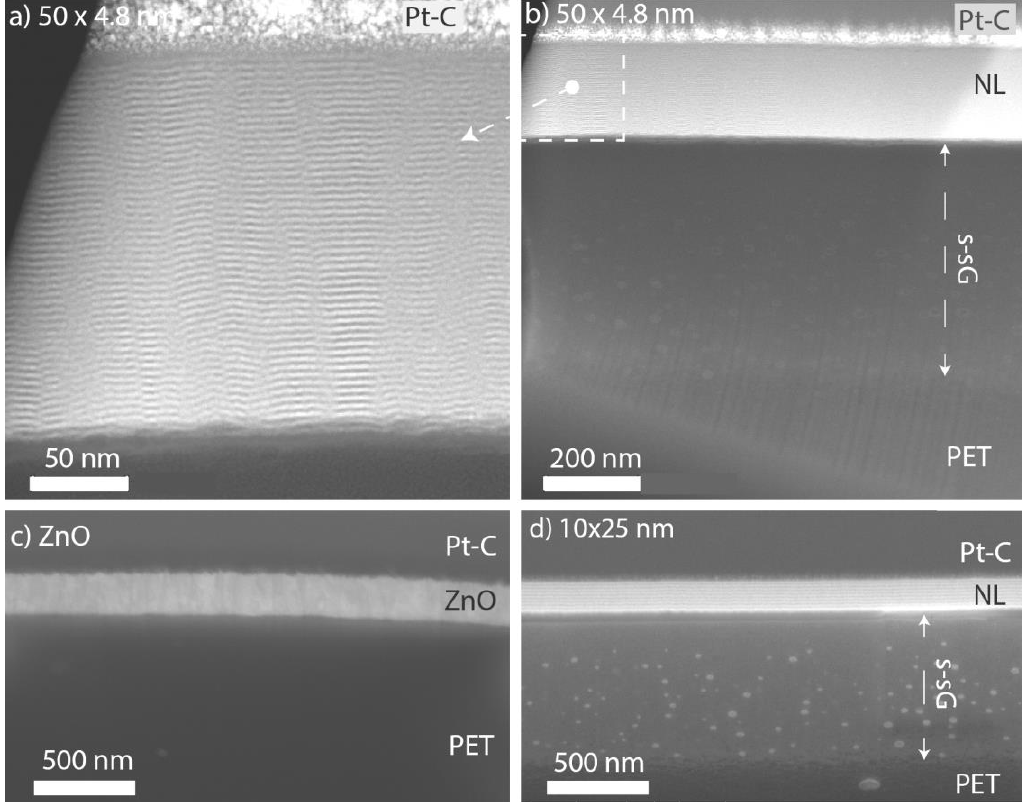
Figure 2. ( a ) and ( b ) STEM cross-sections of the 50 × 4.8 nm Al 2 O 3 /ZnO nanolaminate on PET sample (NL = nanolaminates, s-sG = sub-surface growth, Pt-C = local protection material deposited by FIB for FIB cut). SEM of FIB cut cross-sections of ( c ) the ZnO film and ( d ) the 10 × 25 nm nanolaminate (52° angle). Images were taken after tensile strain experiments. Note the sub-surface growth (s-sG) for ALD films starting with Al 2 O 3 in ( b ) and ( d ).